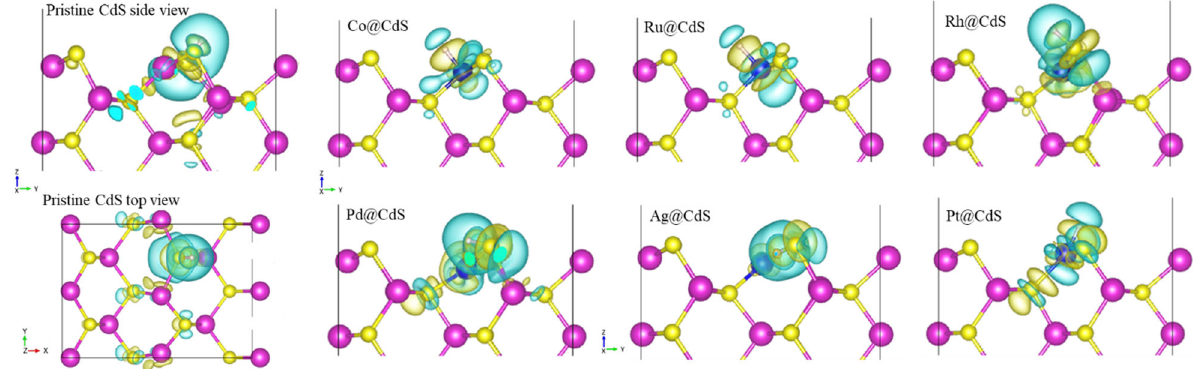
Fig. 8 The charge density difference of the optimized H adsorption on the pristine CdS (110) surface and TM@CdS surfaces. Same color code as Fig. 1, with H = white. Yellow (blue) isosurfaces represent electron accumulation (depletion)